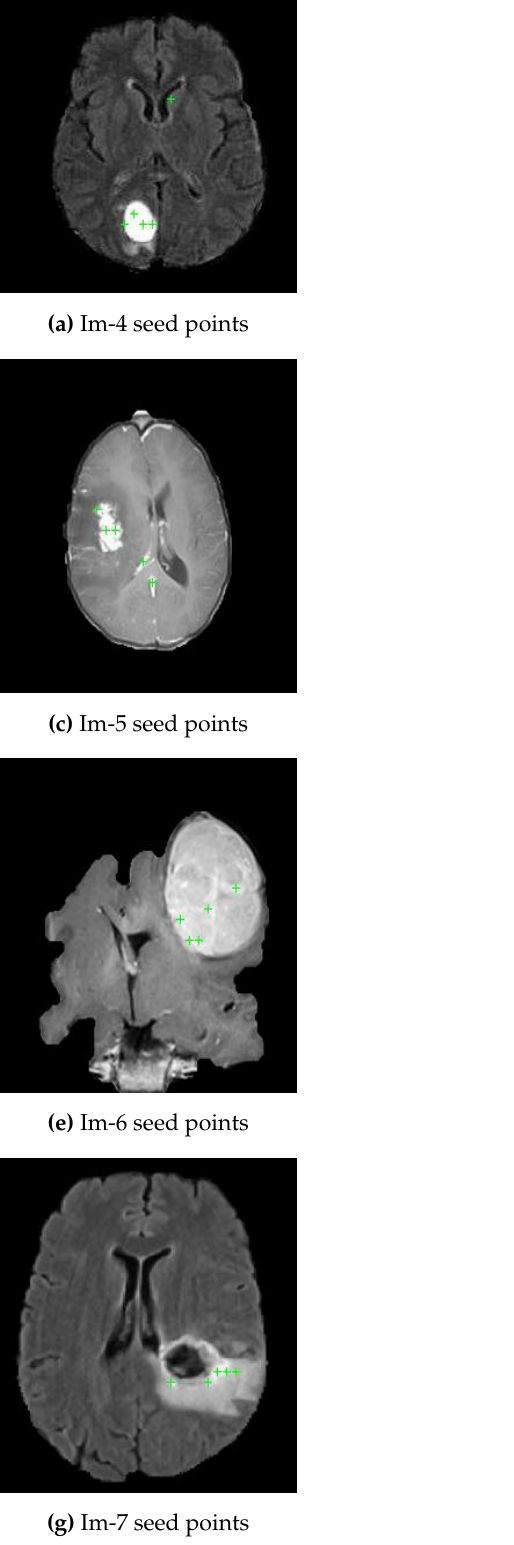
Figure 3. Generated possible seed points and annotations using proposed approach. ( a , c , e , g ) represent a skull removed original brain images with five potential seed points for brain images; ( b , d , f , h ) represent the best ROIs of each respective brain